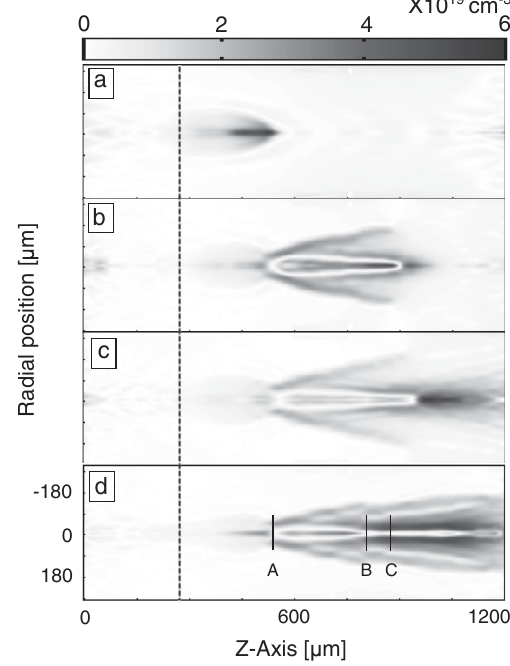
FIG. 6. Restored electron density distribution of the plasma channel for P ¼ 0 : 3 TW (the pulse energy 90 mJ and pulse duration 0.3 ps) and 1 : 5 (cid:3) 10 19 cm (cid:4) 3 gas density at different times. Parts (a)–(d) show the interferograms at different time delays: (a) 1 ps, (b) 3 ps, (c) 5 ps, (d) 9 ps.